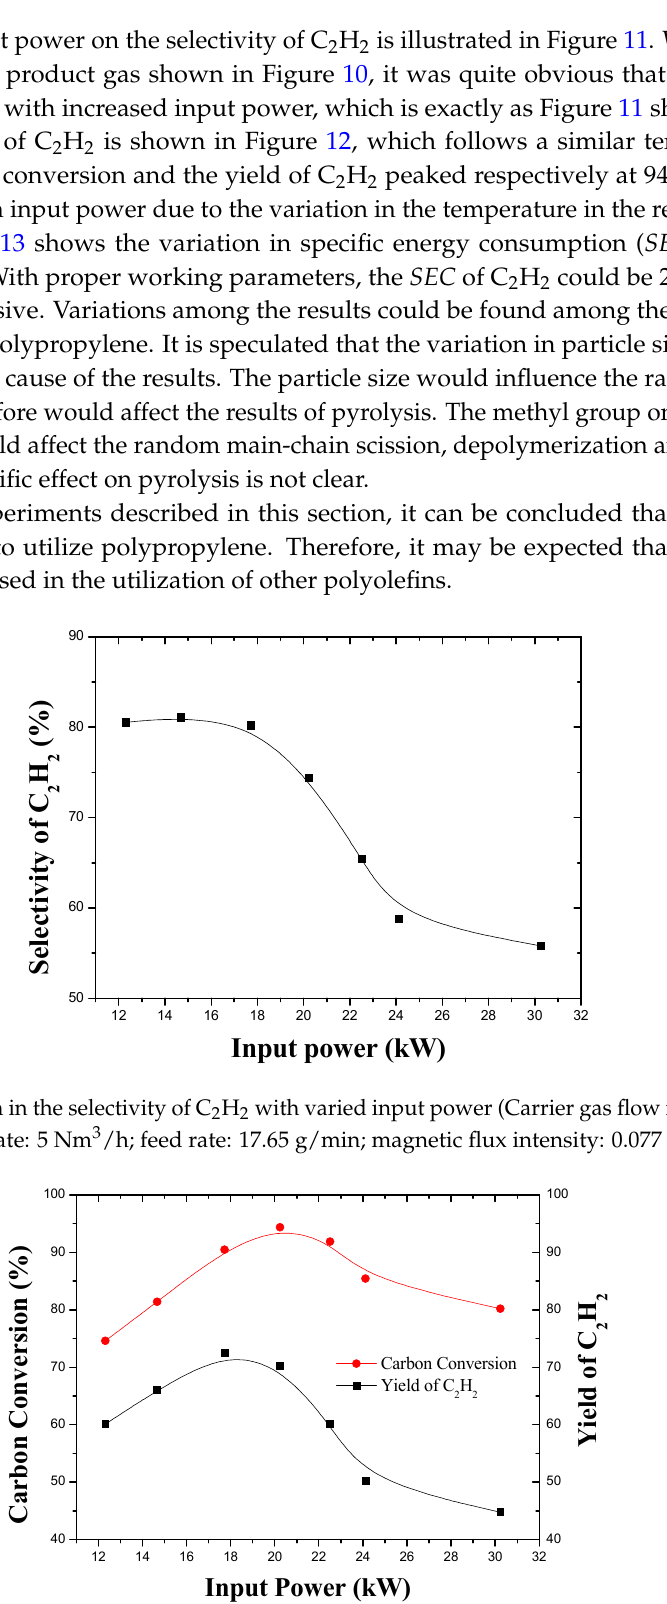
Figure 12. Variation in carbon conversion and the yield of C 2 H 2 with varied input power (Carrier gas flow rate: 1 Nm 3 /h; working gas flow rate: 5 Nm 3 /h; feed rate: 17.65 g/min; magnetic flux intensity: 0.077 T).